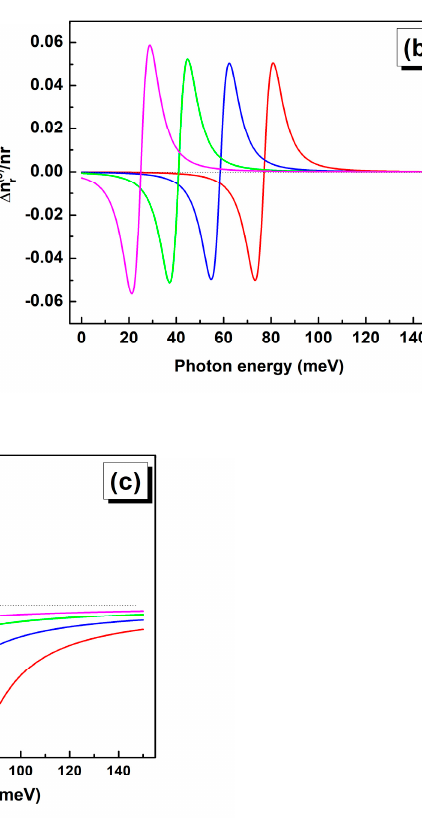
Figure 4. Calculated linear ( a ), 3rd order nonlinear ( b ) and total refractive index changes (RIC) ( c ) as a function of the photon energy for different QD sizes: D = 20 nm (red), D = 26 nm (blue), D = 32 nm (green), D = 40 nm (pink).